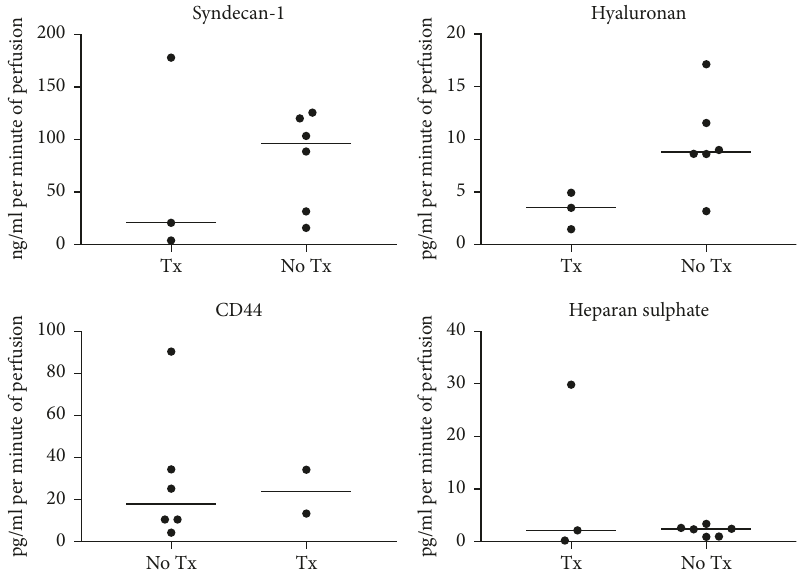
Figure 3: Rate of accumulation of perfusate endothelial glycocalyx breakdown products by outcomes (transplanted (Tx) vs not transplanted (No Tx)). None of the differences are statistically significant.